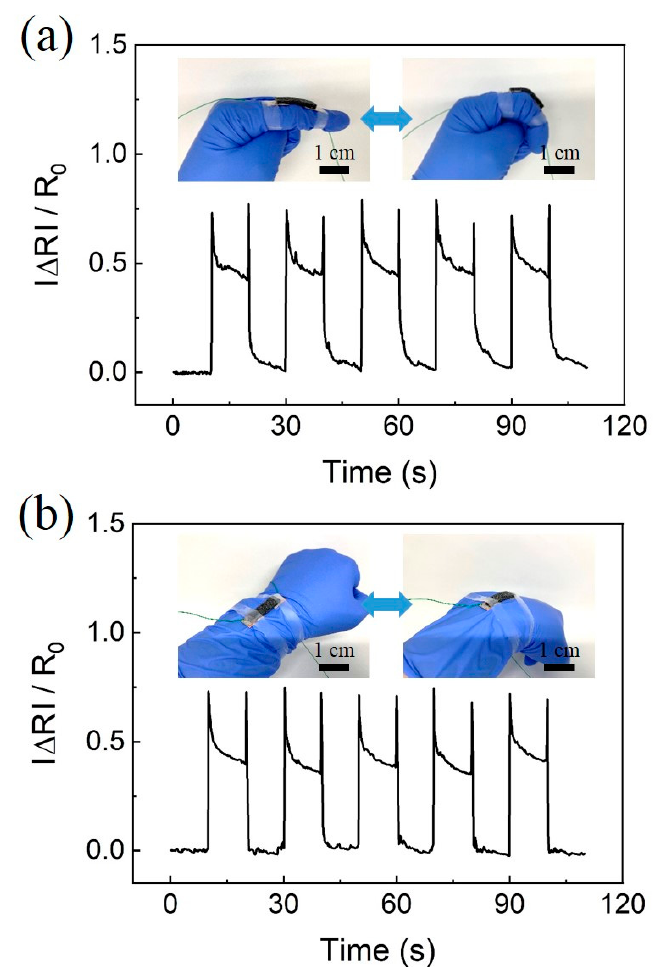
Figure 9. Demonstration of the applicability of pressure sensors based on CPCS. ( a ) Measurement of human motion during finger bending. ( b ) Measurement of human motion during wrist bending. The insets show the images of the sensors attached to the finger and wrist. The sensor is in relaxed and bent states, which correspond to bending angles of 0° and 30°, respectively.